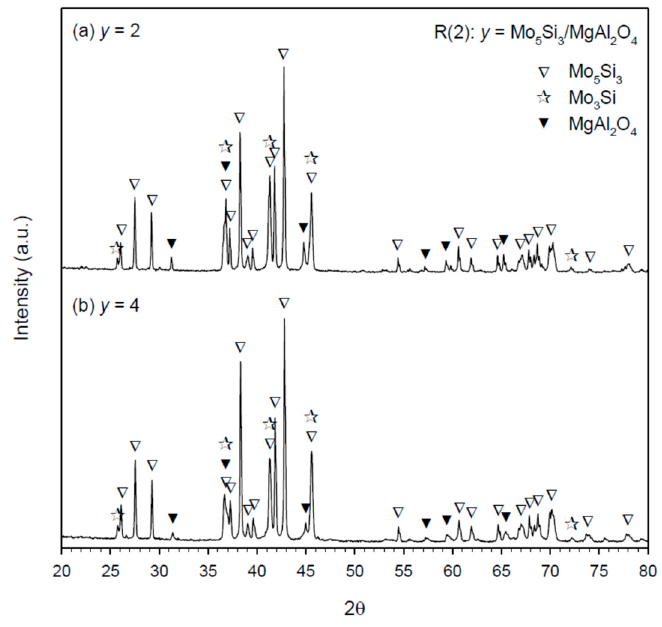
Figure 6. XRD patterns of as-synthesized Mo 5 Si 3 –MgAl 2 O 4 composites from R(2) with ( a ) y = 2 and ( b ) y = 4.